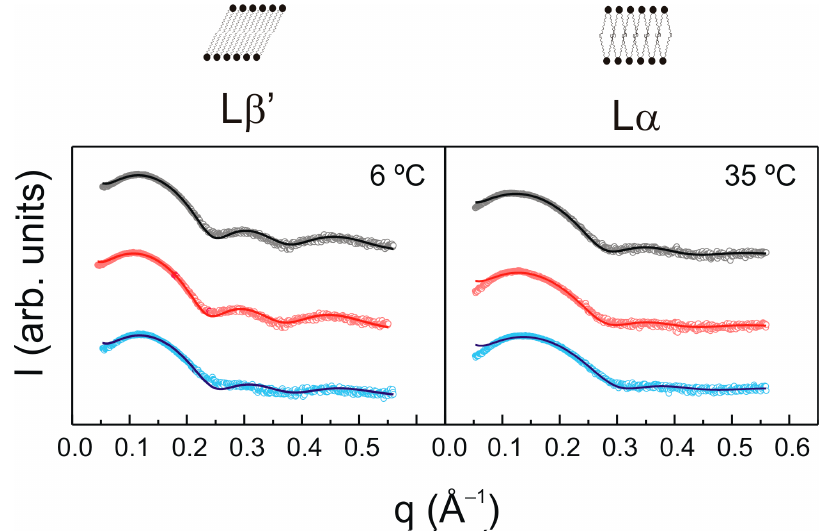
Figure 4. Intensity (arbitrary units log scale) vs. scattering vector ( q ) for SAXD profiles of pure DMPG (top, black) and DMPG containing TMBC at 0.07 (middle, red) and 0.20 mole fraction (bottom, blue) at different temperatures. Solid lines represent the best fit to the experimental patterns using the GAP program.